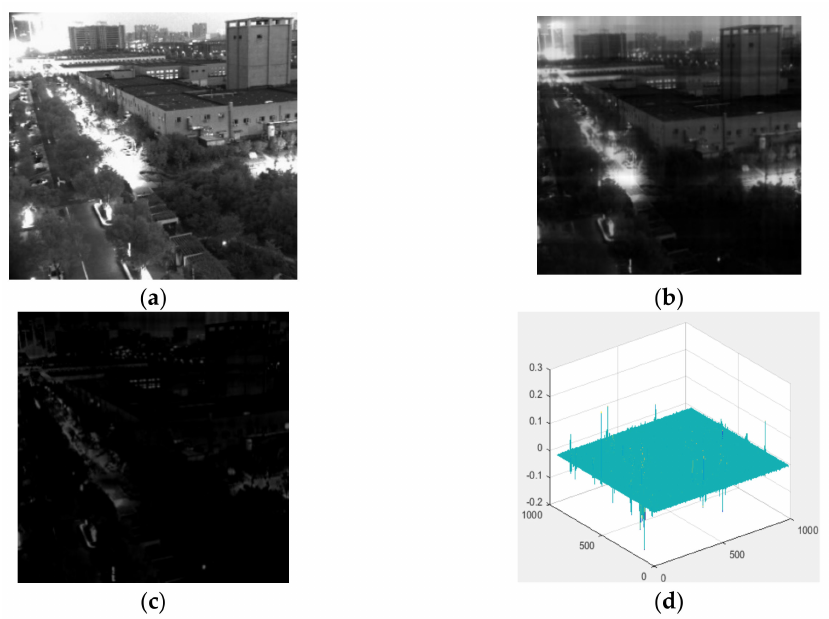
Figure 3. The LatLRR decomposition. ( a ) original image; ( b ) the approximate part; ( c ) the saliency part; ( d ) the sparse